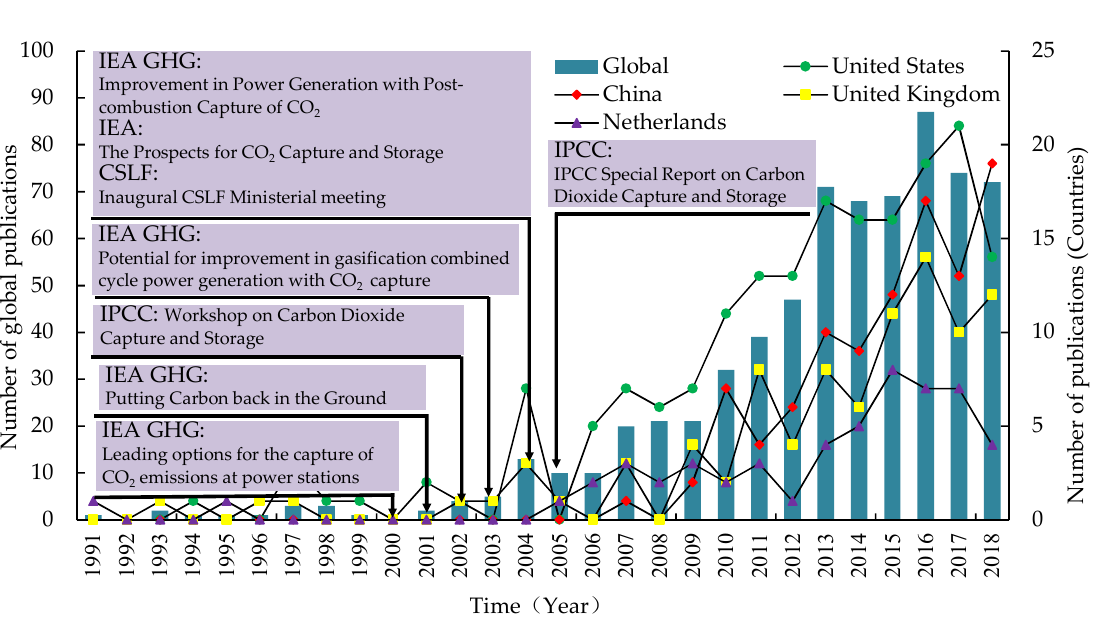
Figure 3. Timeline of publications in the world and top four countries. Energies 2019 , 12 , 23